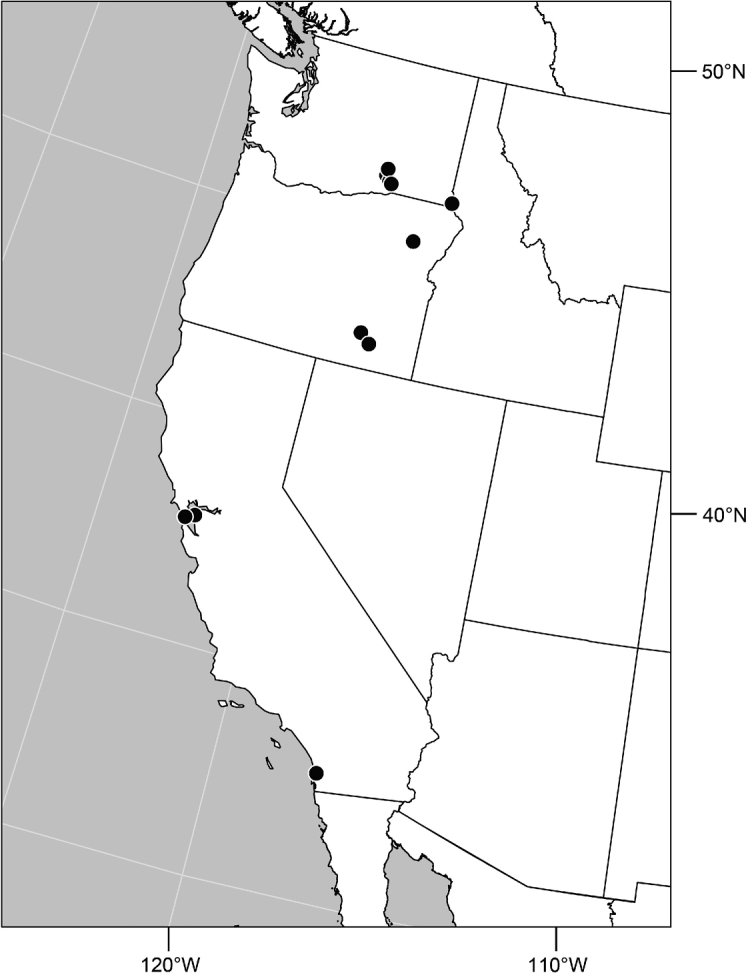
Distribution of Polytrichophora setigera (Cresson).